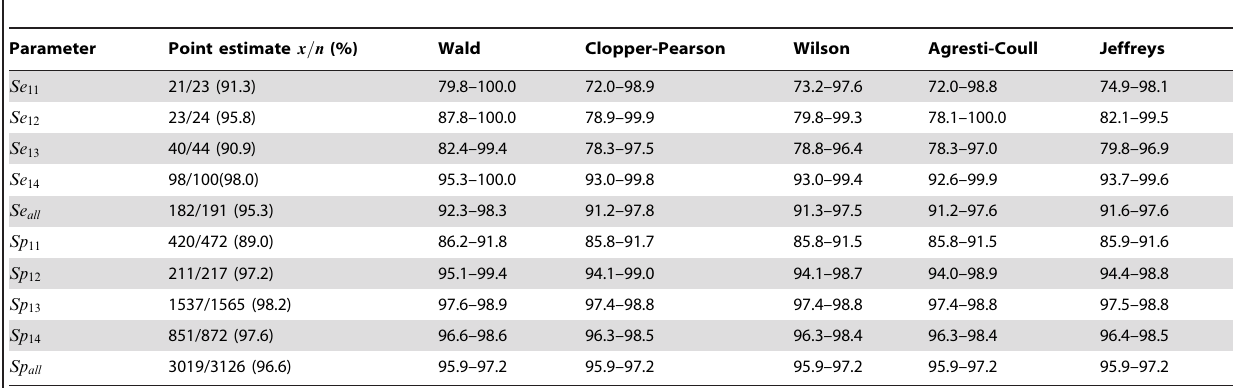
Table 8. Point estimates and 95% confidence intervals, though five different methods, for the sensitivity and the specificity of RDT in each subpopulation j ( Se 1 j and Sp 1 j ) and overall ( Se all and Sp all ), using microscopy as a gold standard.